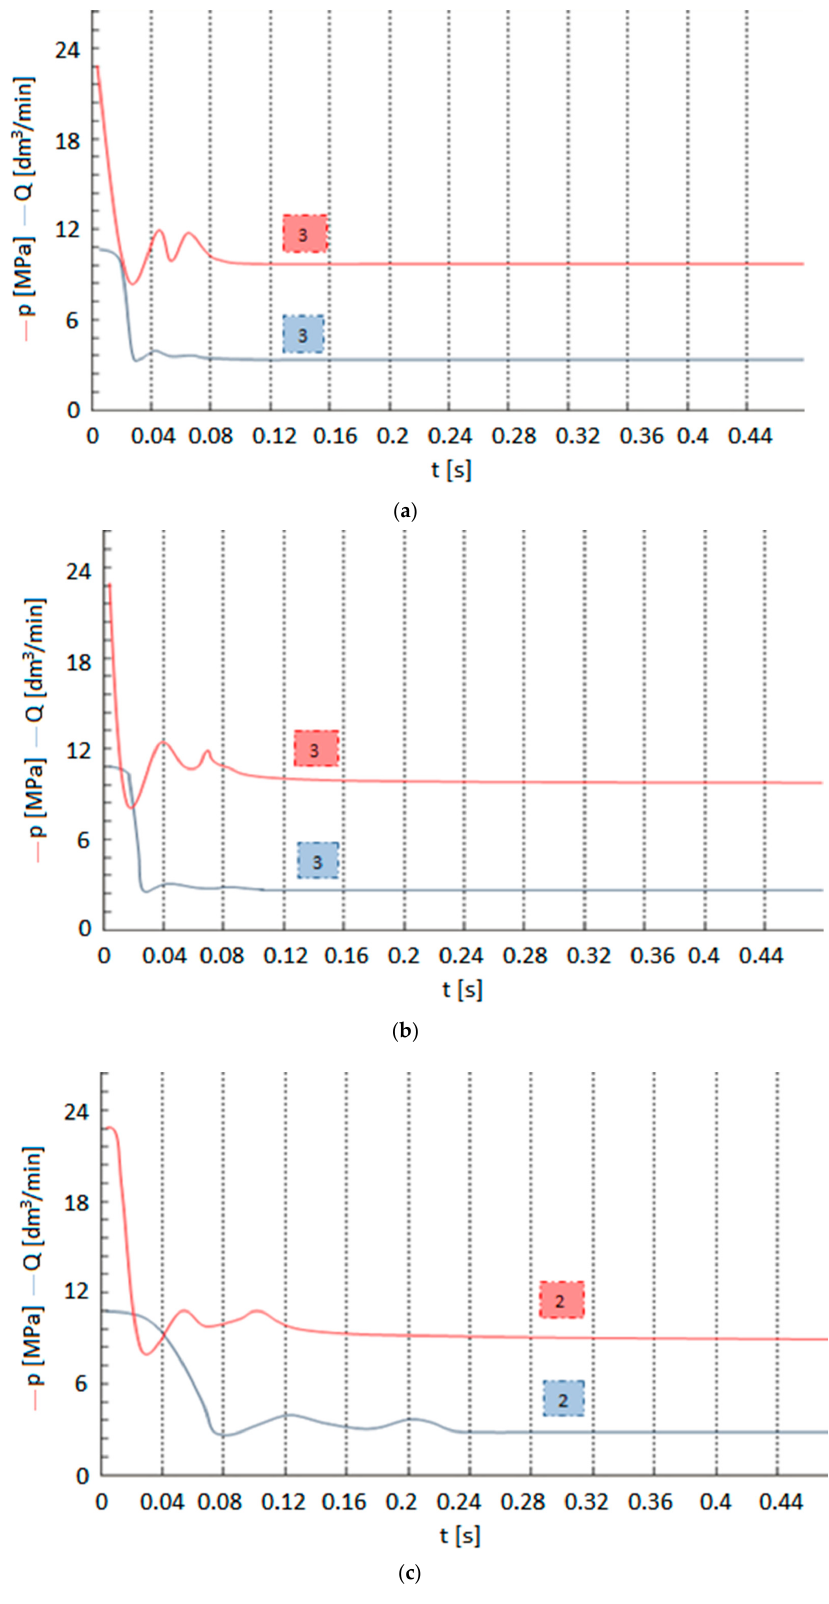
Figure 10. The Q and p time periods for code changes of the K p1 ·K p2 , Q rz , and F m parameters where Q rz Q